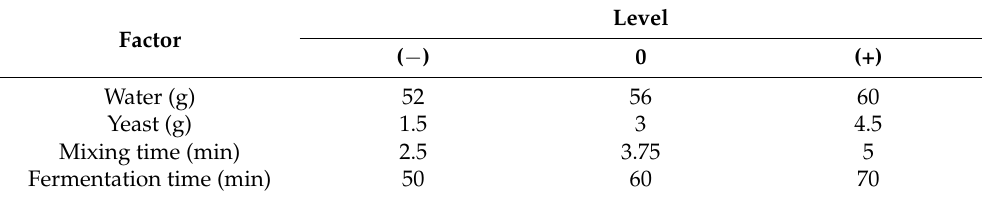
Table 2. Factorsandlevelsofeachfactorinanexperimentaldesignbasedonresponsesurfacemethodology.